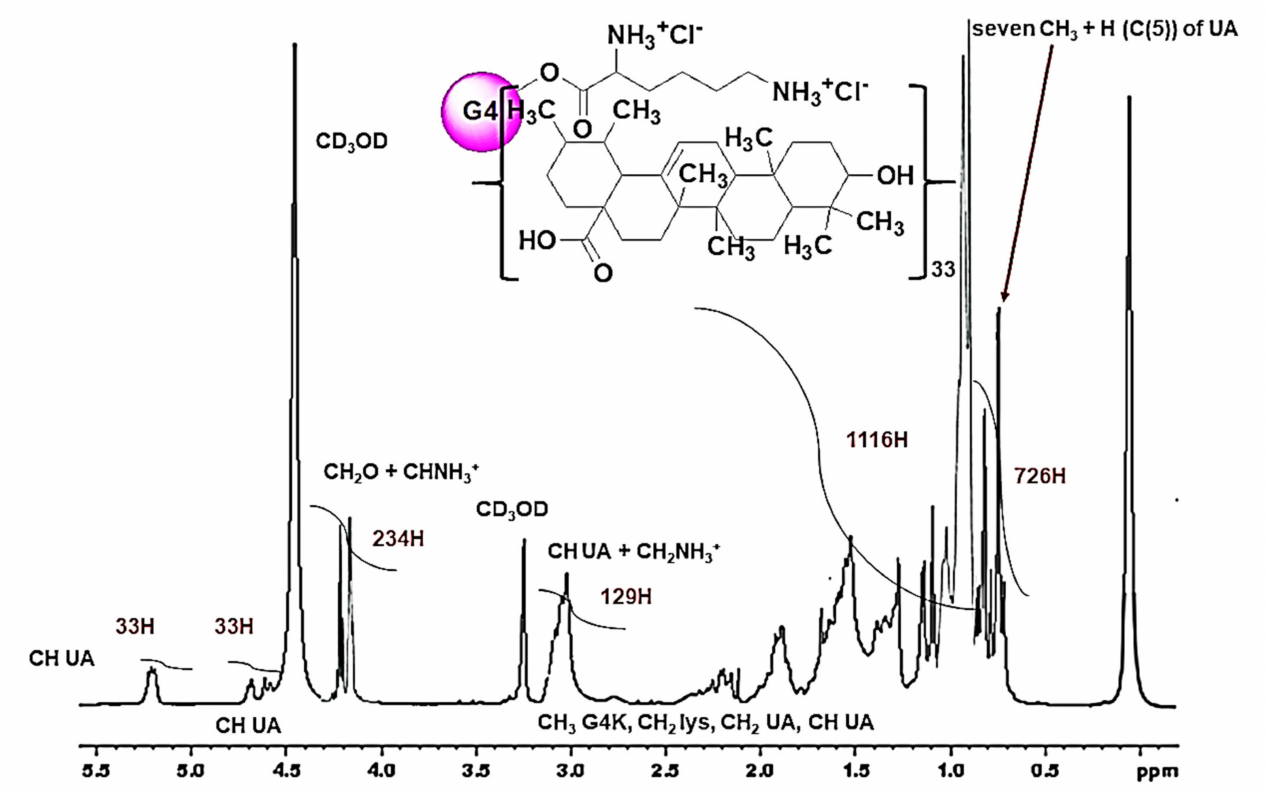
Figure 6. 1 H NMR spectra (CD 3 OD, 400 MHz) of UA-G4K.